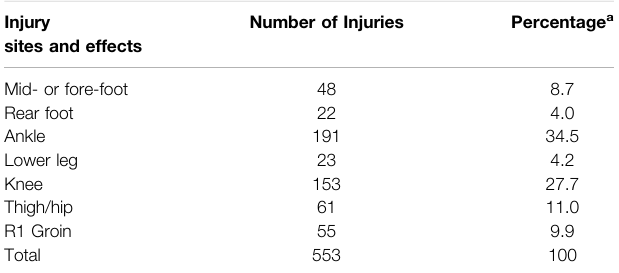
TABLE 1| Distribution ofinjury tothe bilateral lower extremities sustained over the past 2 years. Injury sites and effects